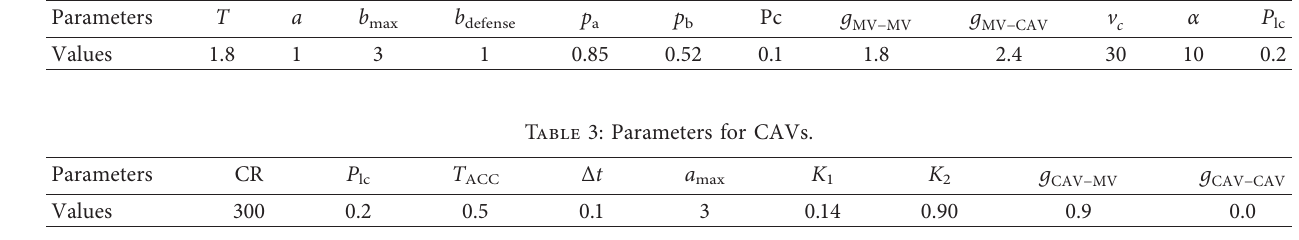
Table 2: Parameters for MVs.